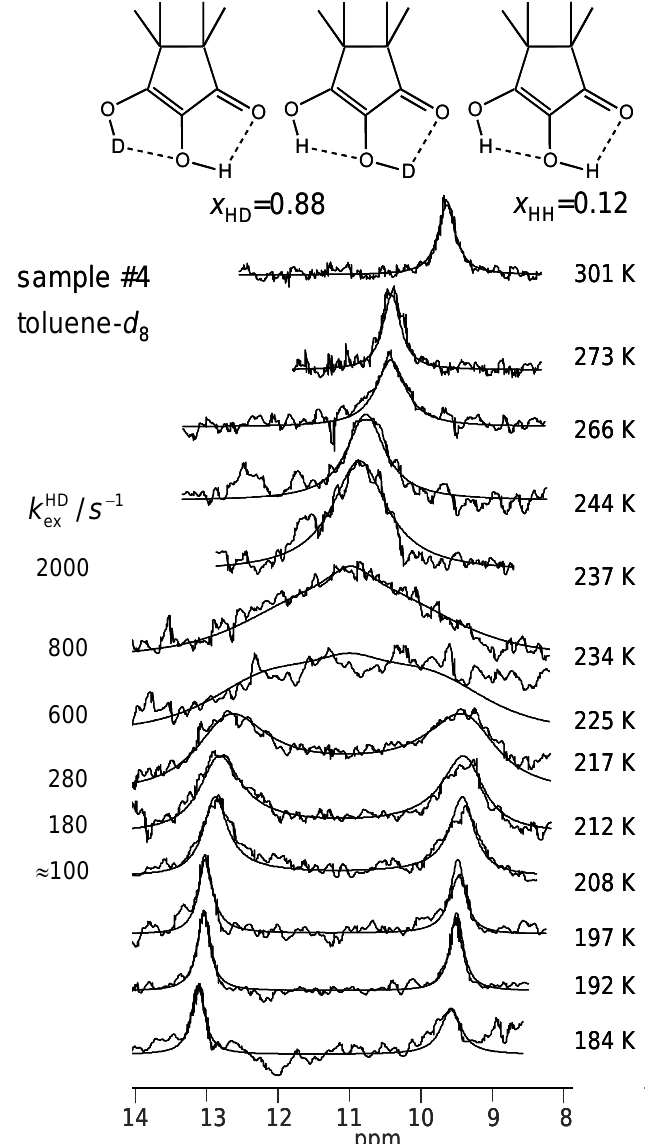
Figure 10. Variable temperature superimposed experimental and simulated 1 H NMR signals of the partially deuterated hydroxyl groups of TMRA dissolved in toluene- d 8 (sample #4, deuterium fraction X D = 0.88, see Section 2.4). The simulation parameters are assembled in Table 2. For further explanation see text.